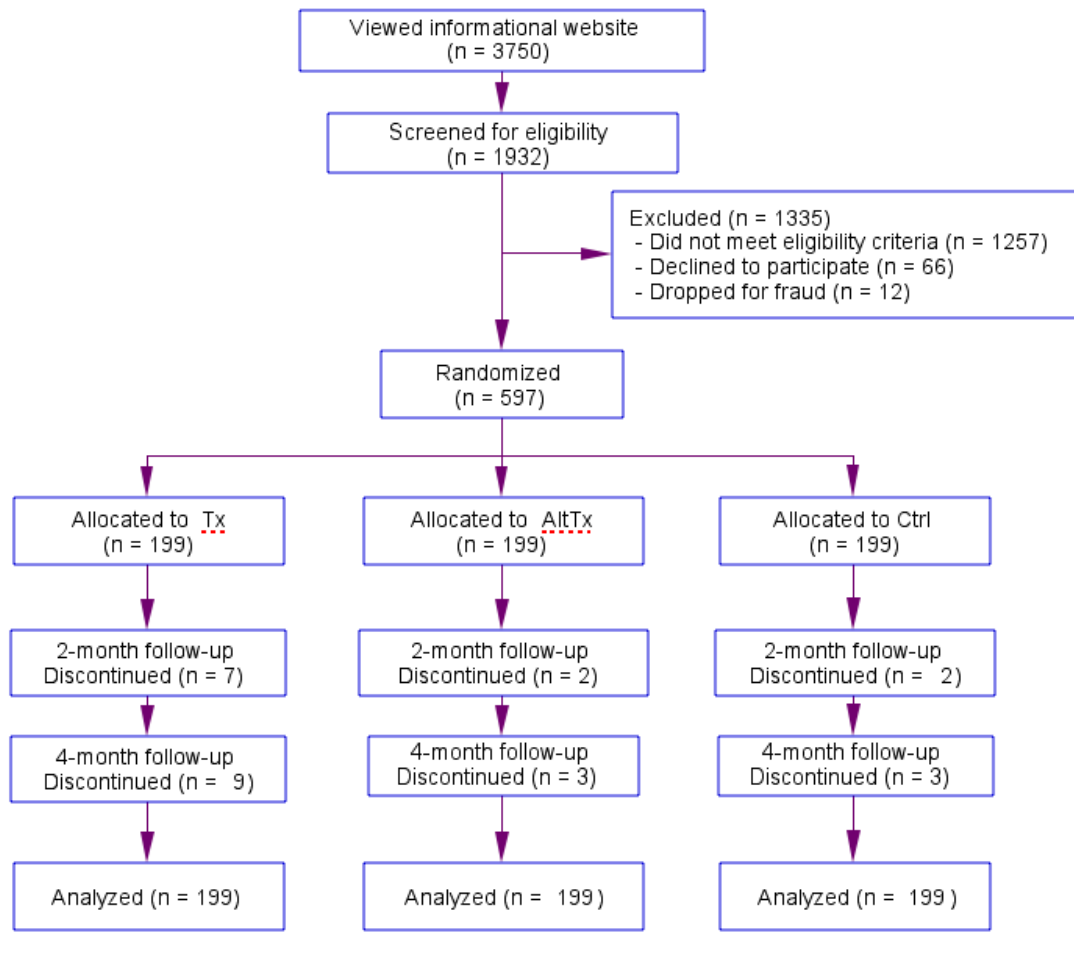
Figure 2. Research design flowchart for FitBack program